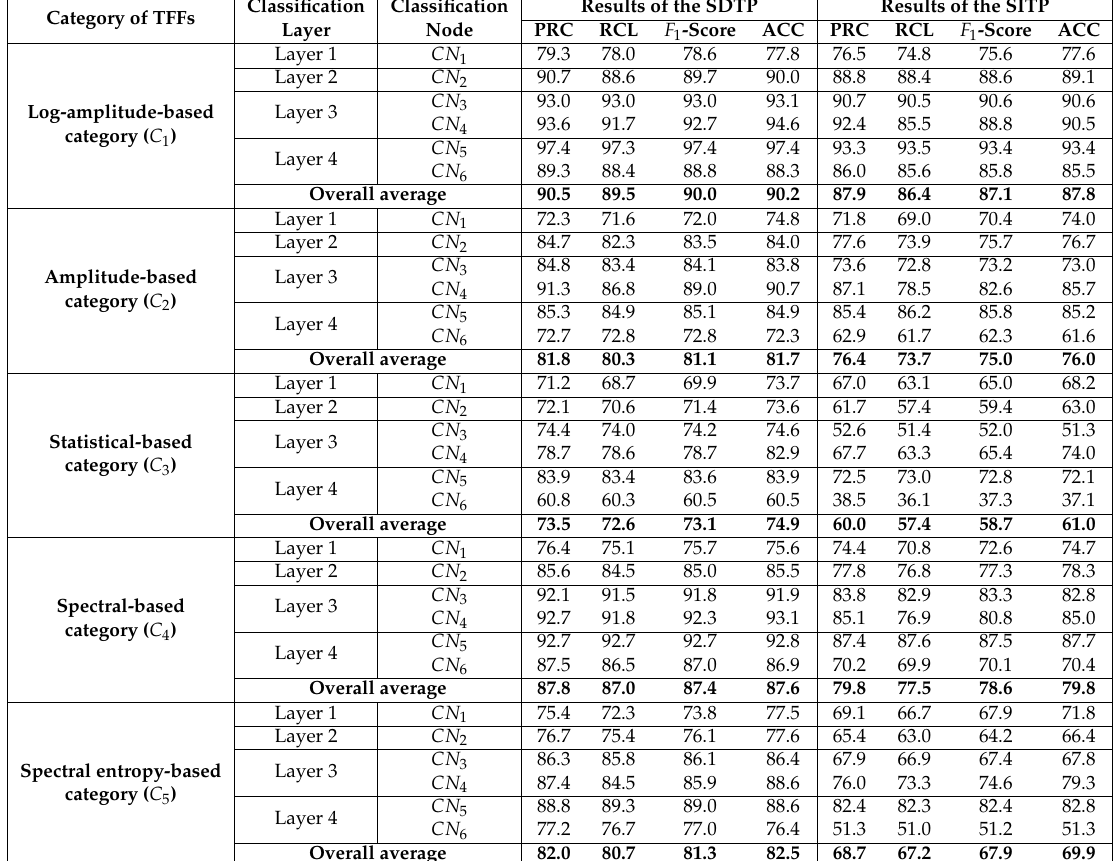
Table 6. Results of the TFF-based analysis obtained using the SDTP and SITP for the amputated subjects in DB 2